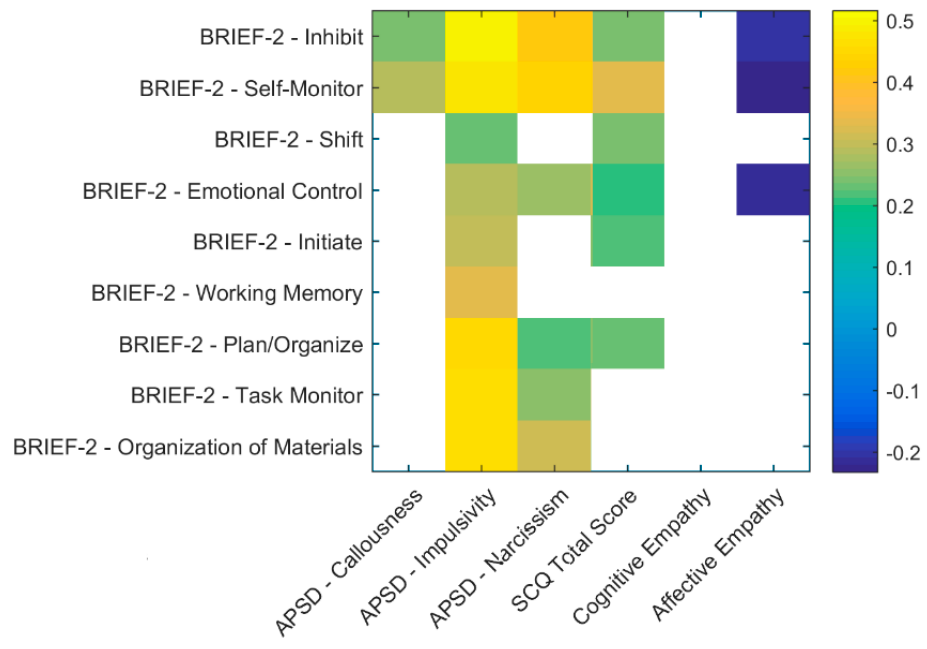
Figure 2. Figure 2. Correlations.